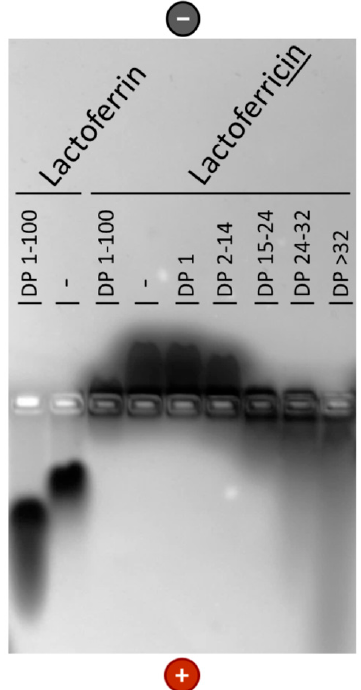
Figure 3. PolySia interacting comparably with ( a ) human and ( b ) bovine lactoferrin. The interaction of polySia with human and bovine lactoferrin was analyzed using a native agarose gel system. The lactoferrin (8 µ g; molecular weight of lactoferrin: bovine, 87 kDa; human, 82 kDa) was incubated with different amounts of polySia and subsequently separated through electrophoresis. Proteins were stained using Coomassie blue.